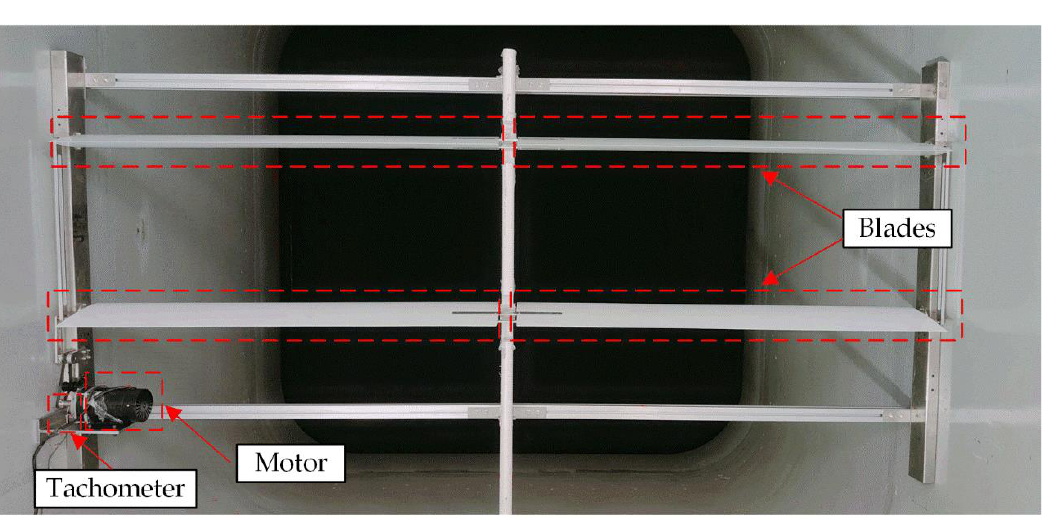
Figure 5. Comparison between measured gust profile and ideal sine gust profile. 3.2. Gust Sensor and Plunging – Pitching Motion Device During the test, a five-hole probe (Figure 6) was used to measure the gusts in the wind tunnel flow field. The measured gusts were processed and used as the input signal for the FFCS. The five-hole probe is capable of measuring various aerodynamic parame- ters, such as the AOA, AOS, and wind speed. When compared with flow vane sensors, this type of device has no mechanical friction and rotation overshoot, so it has higher measurement accuracy and faster dynamic characteristics, making it more suitable for measuring rapidly changing gusts.